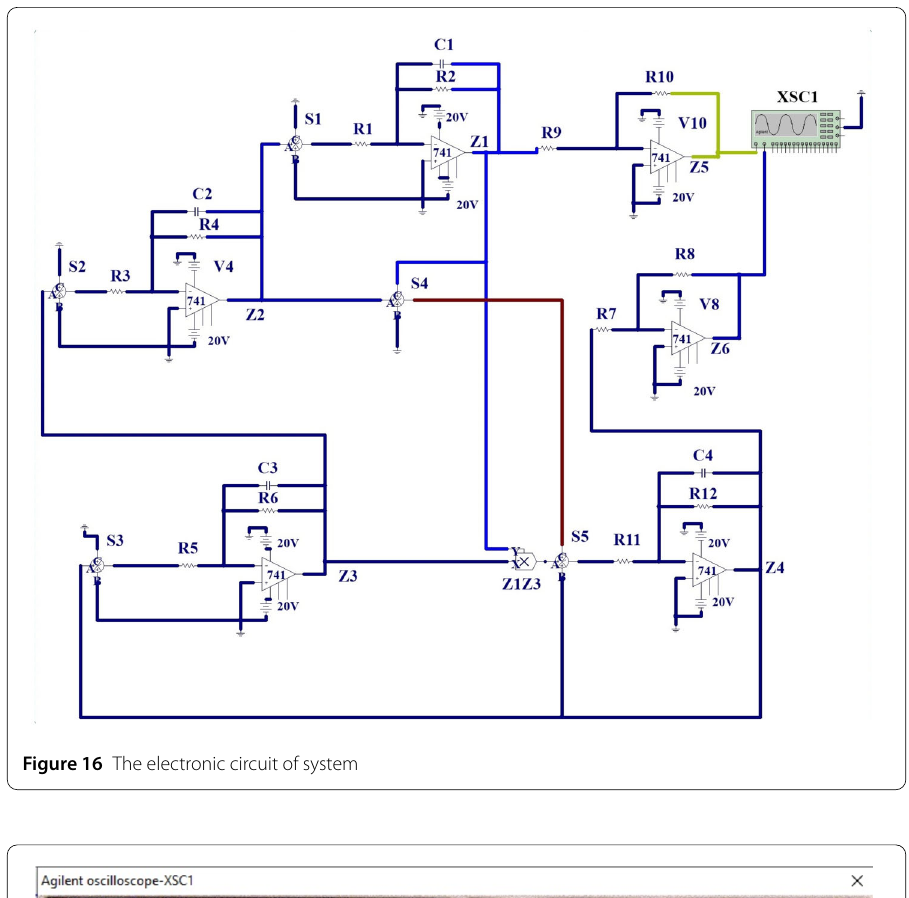
Figure 16 The electronic circuit of system